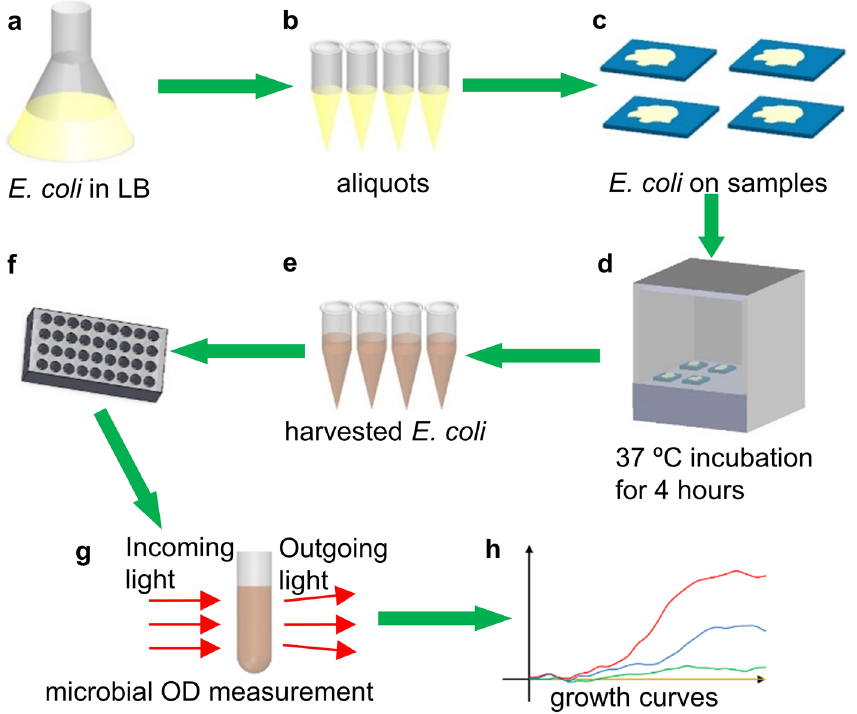
Figure 3. Procedures of the biological test. ( a ) Cultivating E. coli , ( b ) aliquots of E. coli after dilution, ( c ) application on samples, ( d ) incubation at 37° for 4 h, ( e ) dilution after harvesting E. coli from samples, ( f ) dispensing into test tubes, ( g ) microbial OD measurement, ( h ) growth curves